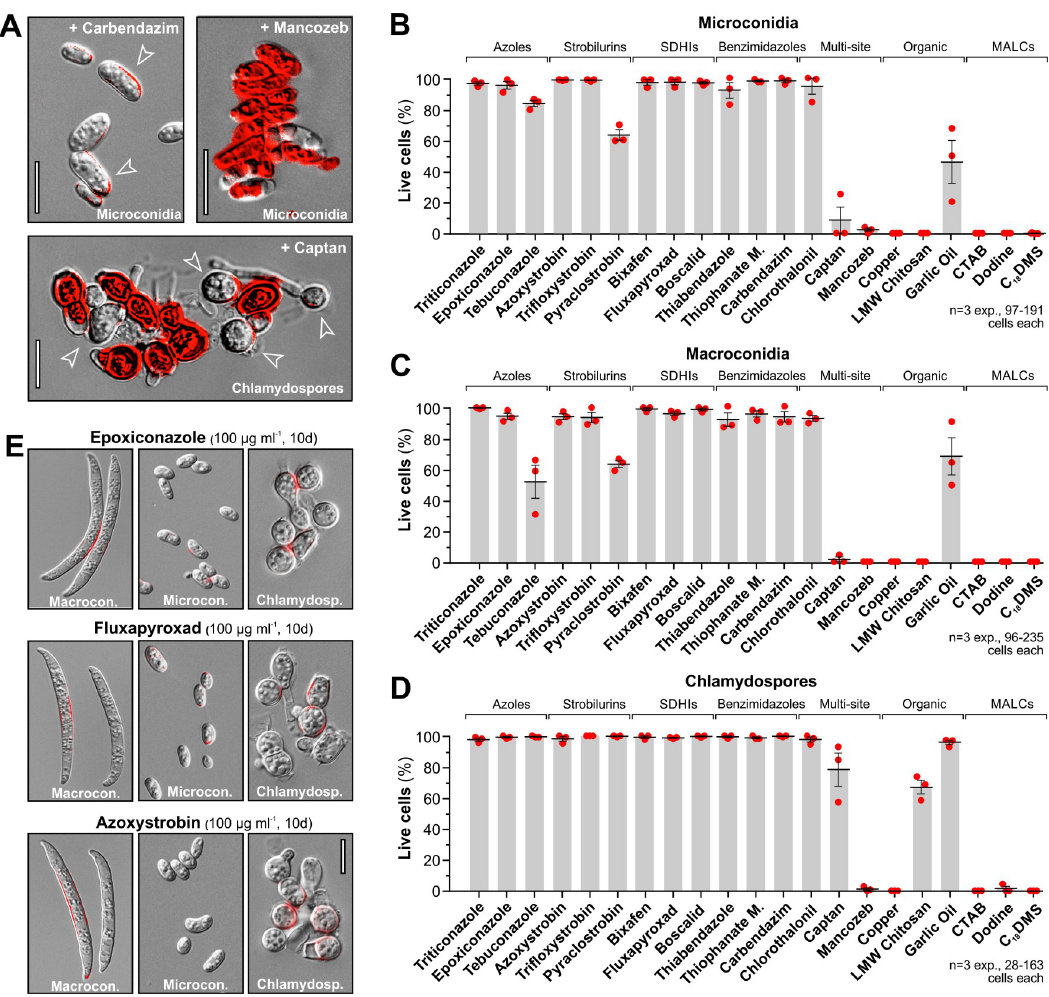
Fig 6. Fungicide sensitivity of FocTR4 spores in liquid culture. A Examples of LIVE/DEAD dye-stained microconidia and chlamydospores after 10 days in ddH 2 O, supplemented with carbendazim, mancozeb or captan. Living cells exclude the dye and often accumulate it in the cell wall (open arrowheads); dead cells fluoresce red. Scale bars = 10 μ m. B Relative number of living microconidia (LIVE/DEAD staining negative) after 10 d-treatment with fungicides; fungicide classes are indicated above parenthesis. C Relative number of living macroconidia (LIVE/DEAD staining negative) after 10 d-treatment with fungicides; fungicide classes are indicated above parenthesis. D Relative number of living chlamydospores (LIVE/DEAD staining negative) after 10 d-treatment with fungicides; fungicide classes are indicated above parenthesis. E Morphology and LIVE/DEAD staining of microconidia, macroconidia and chlamydospores after 10 day-incubation in SDW, supplemented with epoxiconazole, fluxapyroxad and azoxystrobin (all 100 μ g ml -1 ). Note that all spore forms can persist at high concentration of fungicides. Scale bar = 10 μ m. Bars shown in ( B — D ) represent the mean proportion ( ± SEM) of cells that did not take up LIVE/DEAD staining, thus were considered alive; red dots represent averages of 3 independent experiments. All spore types in ( B—D ) were incubated for 10 days in SDW at 25˚C and under rotation; concentrations used were in category I (= inhibition on agar plates at < 10 μ g ml -1 ): thiabendazole, 10 μ g ml -1 ; carbendazim, 4.5 μ g ml -1 ; chlorothalonil, 5 μ g ml -1 ; captan, 10 μ g ml -1 ; mancozeb, 35 μ g ml -1 ; in category II (= inhibition on agar plates at > 10 μ g ml -1 ): copper, 100 μ g ml -1 (applied as Copper(II) sulfate pentahydrate); LMW chitosan, 100 μ g ml -1 (applied as a lactate salt); garlic oil, 100 μ g ml -1 ; CTAB (Cetrimonium bromide), 100 μ g ml -1 ; dodine, 100 μ g ml -1 ; C 18 DMS; 100 μ g ml -1 ; triticonazole, 100 μ g ml -1 ; epoxiconazole, 100 μ g ml -1 : tebuconazole, 100 μ g ml -1 ; azoxystrobin, 100 μ g ml -1 ; trifloxystrobin, 100 μ g ml -1 ; pyraclostrobin, 100 μ g ml -1 ; bixafen, 100 μ g ml -1 ; fluxapyroxad, 100 μ g ml -1 ; boscalid, 100 μ g ml -1 ; thiophanate methyl, 100 μ g ml -1 ; concentrations in ( e ) are 100 μ g ml -1